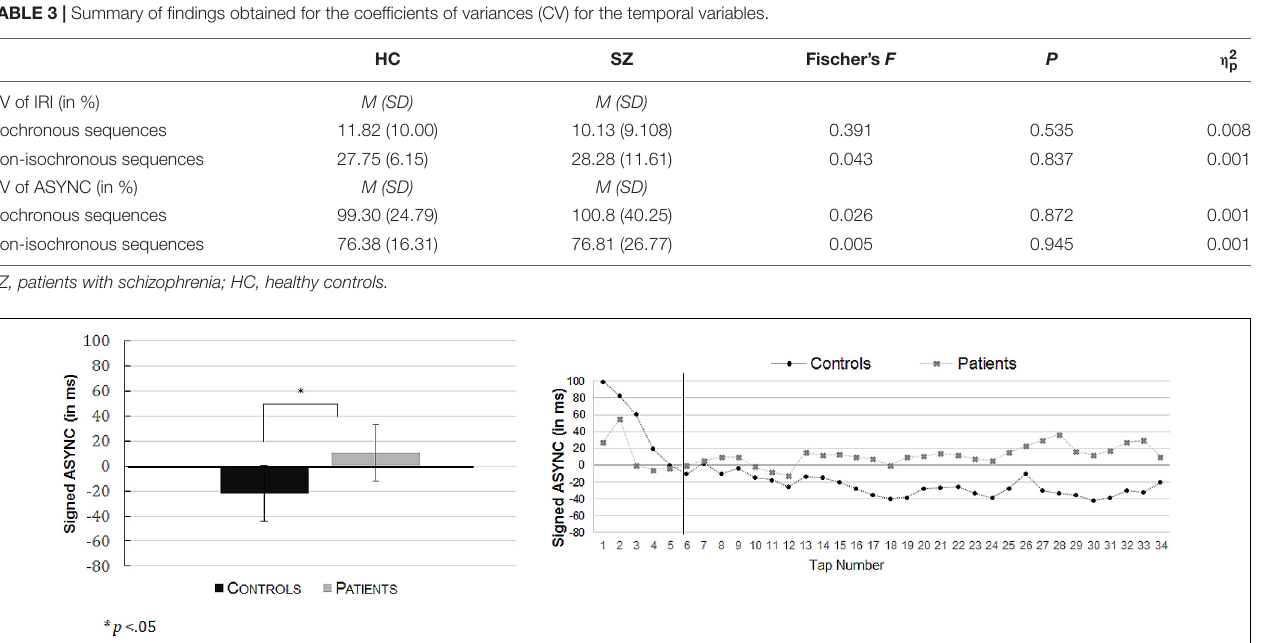
FIGURE 4 | Mean signed asynchronies (ASYNC in ms) (with their respective standard errors) in the equivalent isochronous rhythmic condition ( Left : R-eq) as a function of the group (controls; patients). On the (Right) , the time series of these results are presented for the total of 34 taps in controls (black dots) and in the patients (gray dots). The black vertical line illustrates the boundary from which the first six taps of each trial was discarded for the analyses. Indeed, it took a few beats for the participants to get into the pace set by the metronome.